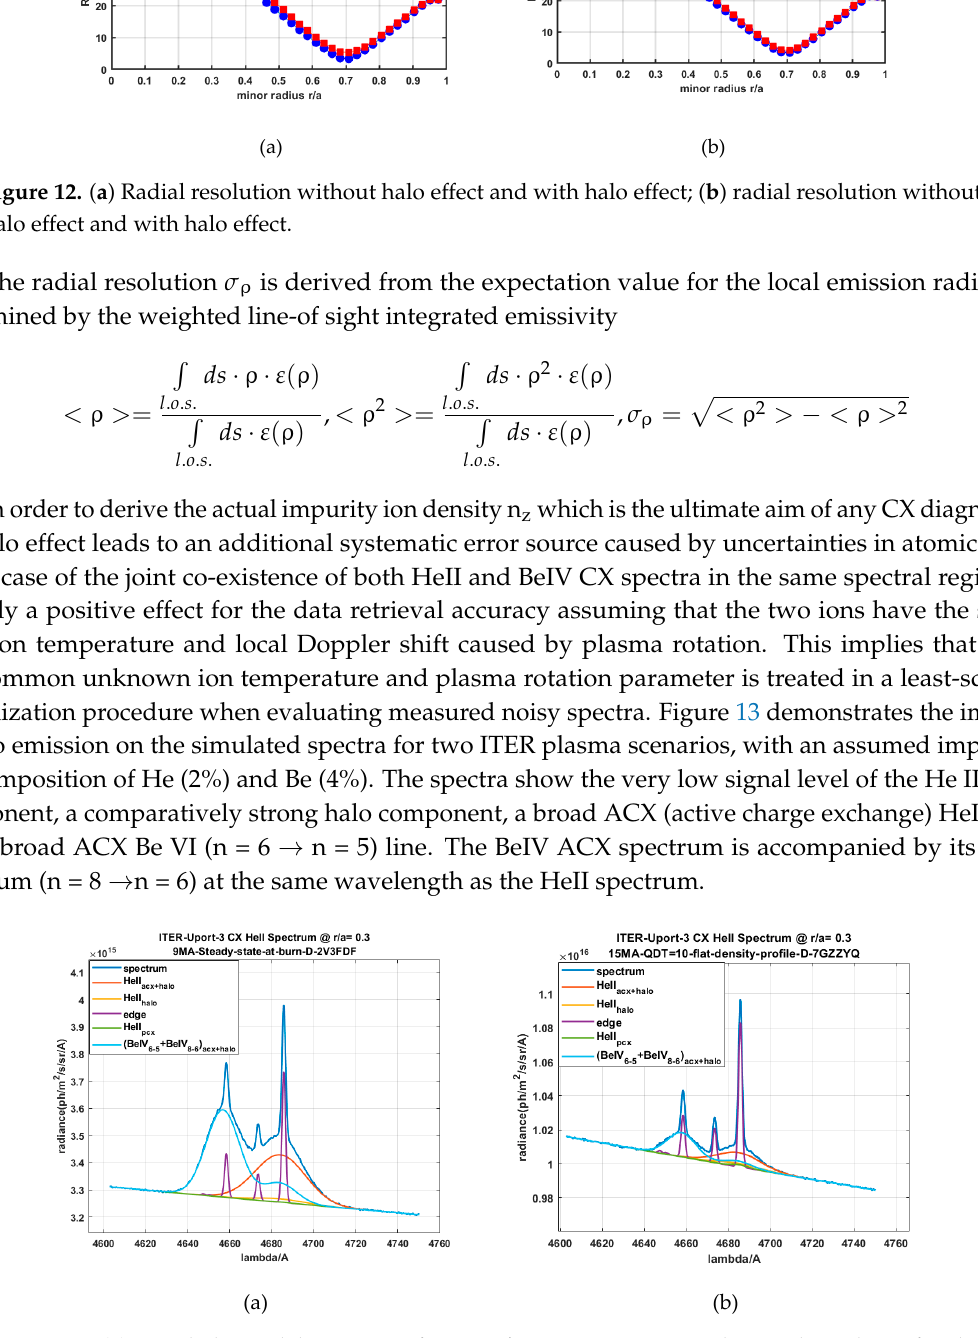
integrated spectra for halo and PCX components is only shown for HeII. Halo fraction 13%